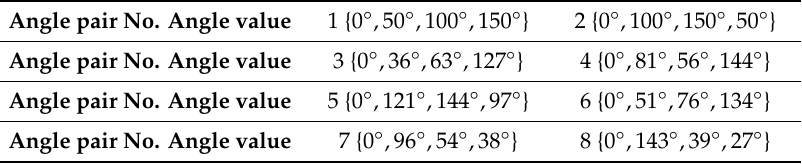
Table 1. Angle pairs selected for the identification.